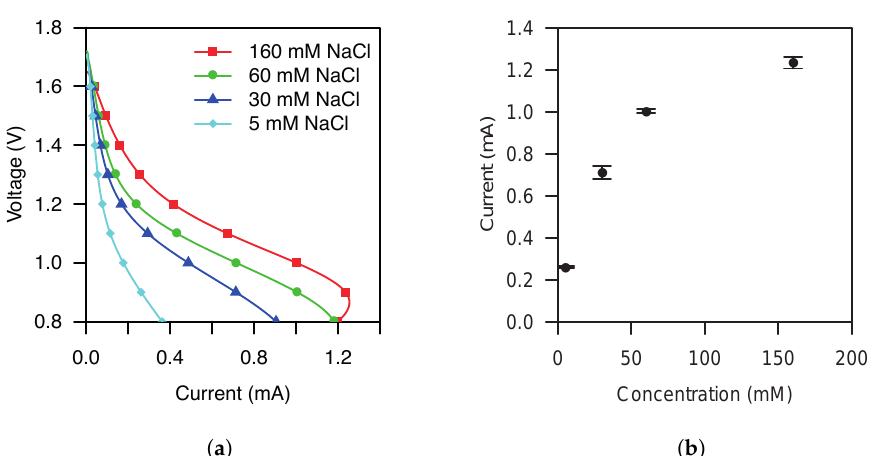
Figure 3. ( a ) Polarization curves of two NaCl-based galvanic cells stacked in series using an open- circuit potential to 0V linear sweep voltammetry with a scan rate of 10mVs − 1 for samples with an increasing conductivity of 5, 30, 60 and 160m M equiv NaCl. ( b ) Current vs. NaCl sample concentration transfer function extracted for a polarization voltage of 0.9V from polarization curves of two NaCl-based galvanic cells stacked in series using an open-circuit potential to 0V linear sweep voltammetry with a scan rate of 10mVs − 1 for samples with an increasing conductivity of 5, 30, 60 and 160m M equiv